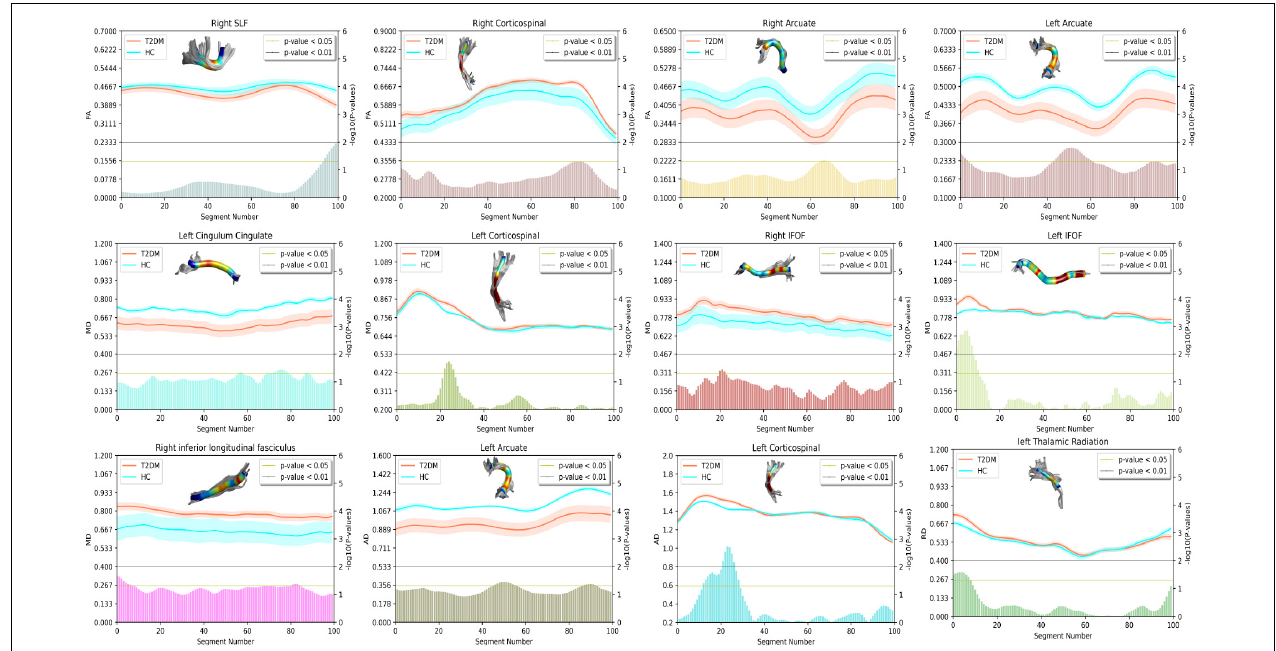
FIGURE 1 | Plots summarizing group differences for diffusion tensor imaging (DTI)-derived indexes. Only fiber tracts with difference after point-wise comparison are shown. The X -axis represents the fiber segment, the left Y -axis represents the average DTI parameters, and the right Y -axis represents the negative logarithm of p -value. In the figure, the yellow horizontal line represents p < 0.05, and the gray horizontal line represents p < 0.01. The figure is plotted using seaborn (https://seaborn.pydata.org/) and AFQ’s function, as well as refer to the relevant contents in the DIPY toolkit (https://dipy.org).